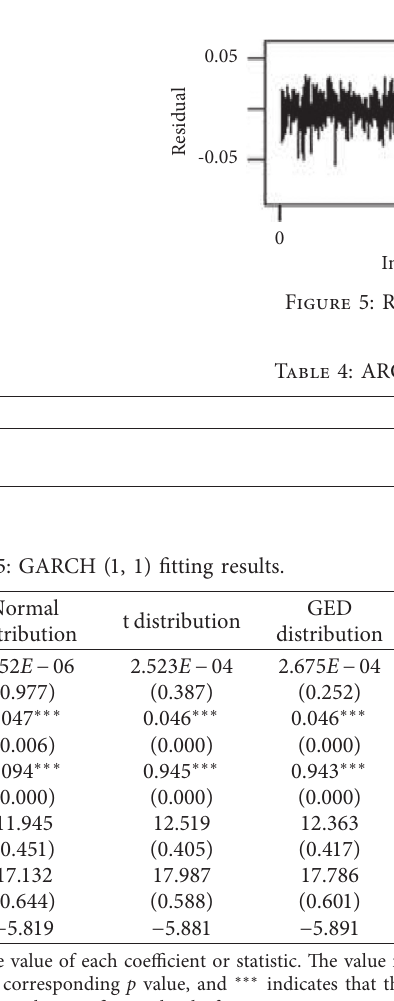
Figure 4: The autocorrelation graph and partial autocorrelation graph of the daily logarithmic return rate.